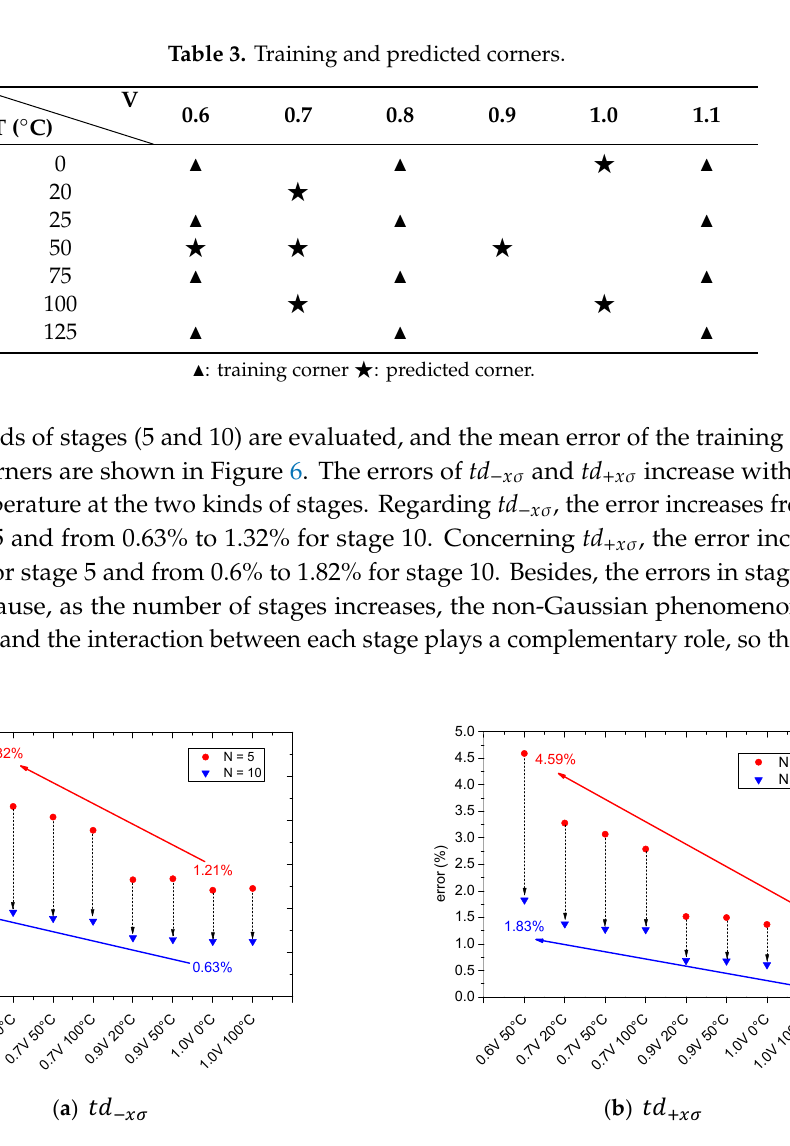
Figure 6. Path variation delay mean error prediction of stage 5 and 10 at multi-corner conditions. ( a ) td − x σ ; ( b ) td + x σ